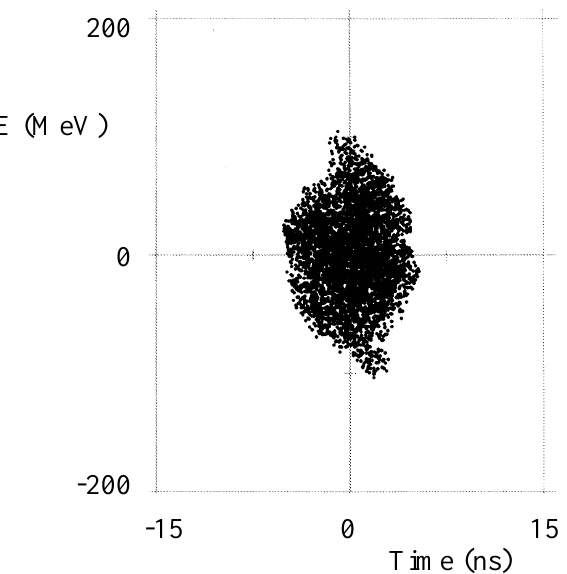
FIG. 11. The final phase space after d (cid:116) is moved close to the beam energy ( g (cid:173) (cid:56)(cid:46)(cid:52)(cid:48)